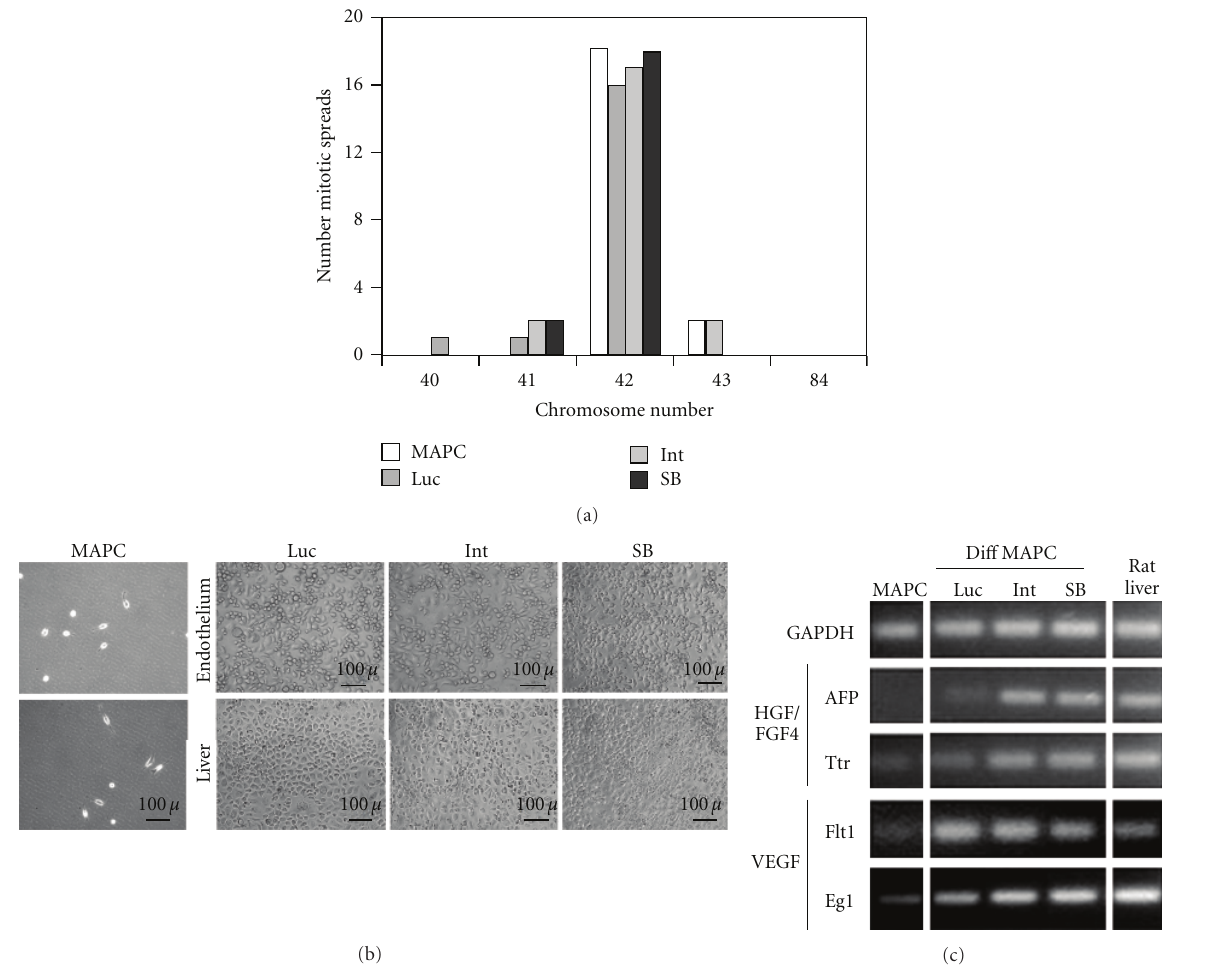
Figure 4: MAPC maintain their stem-cell character and the ability to di ff erentiate following genetic engineering. (a) Karyotypic analysis of pooled G418-resistant cells; the number of mitotic spreads containing the number of chromosomes indicated on the abscissa is indicated. Absence of aneuploid or diploid cells indicates no gross karyotypic anomalies or aberrant cell-cycle activity in the analyzed cells. (b) MAPCs are small spindle-shaped cells that are cultured at very low density. Morphological changes following di ff erentiation into liver and endothelium for two weeks as described in Section 2 show significant di ff erence between cells LUC-, Int- or SB-treated cells. (c) RT-PCR analysis of the di ff erentiated cells shows the presence of alpha-fetoprotein (AFP) and transthyretin (TTR) for liver di ff erentiation, and vascular endothelial growth factor receptor-1 (Flt1) and endothelial-derived gene-1 (Eg1) for di ff erentiation into endothelium. Rat liver was used as a positive control for liver and endothelial markers and undi ff erentiated MAPC used as the negative